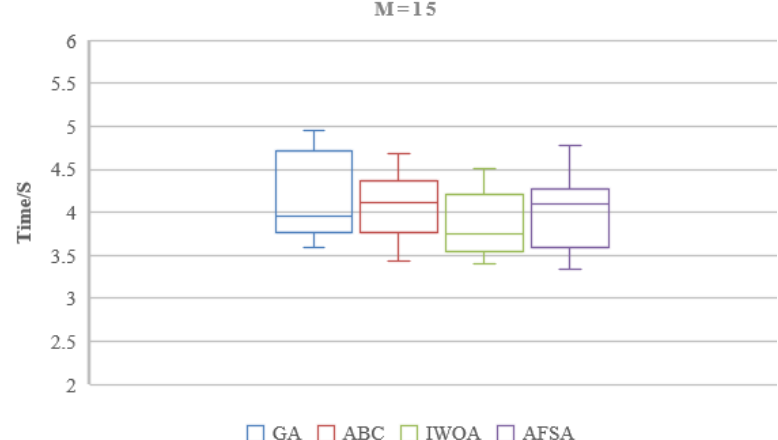
Figure 12. Running time box plot when the population is 5.